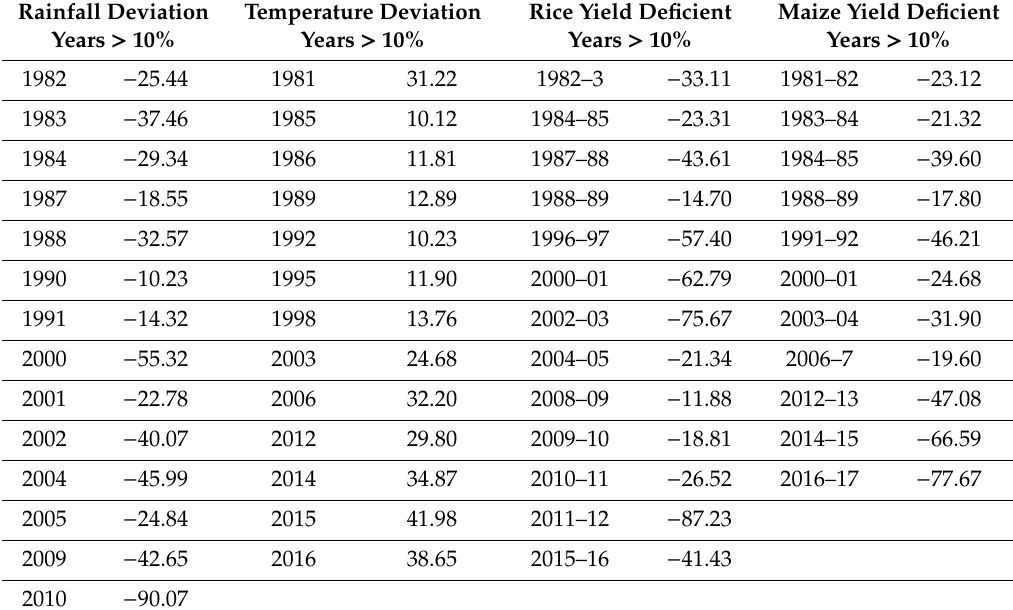
Table 1. Years representing paddy and maize yield deficient years ( > 10%), along with rainfall and temperature deviation years.